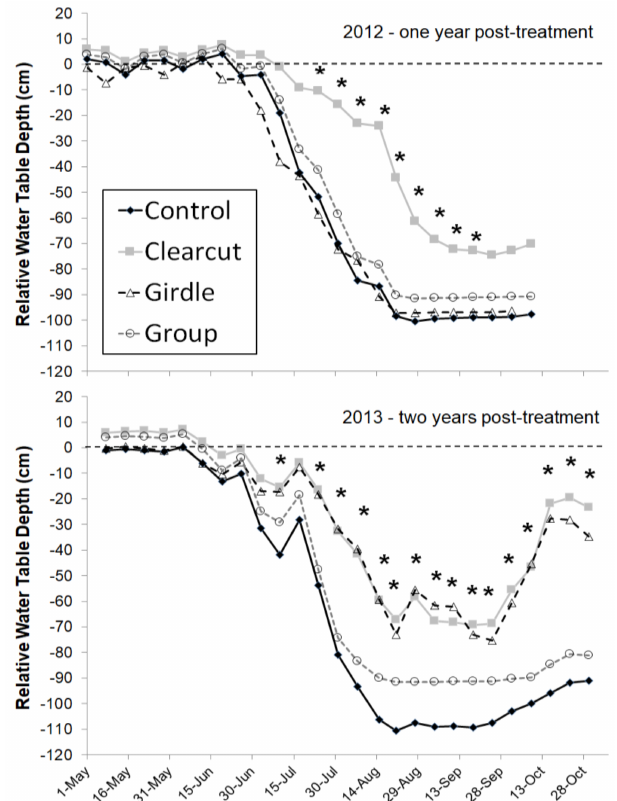
Figure 2. Weekly mean ( n = 6) water table depth relative to ground surface by treatment from the Minnesota sites. The control treatment comprised unharvested reference sites, the clearcut treatment was a commercial harvest, trees were girdled in the girdled treatment, and group treatment was a group selection harvest creating gaps of approximately 0.04 ha. Each year’s growing season was analyzed separately; weeks with an * indicate significant differences among treatments ( p < 0.05). There were no differences among treatments prior to treatment application ( p > 0.2) (reproduced from Slesak et al. [8]).